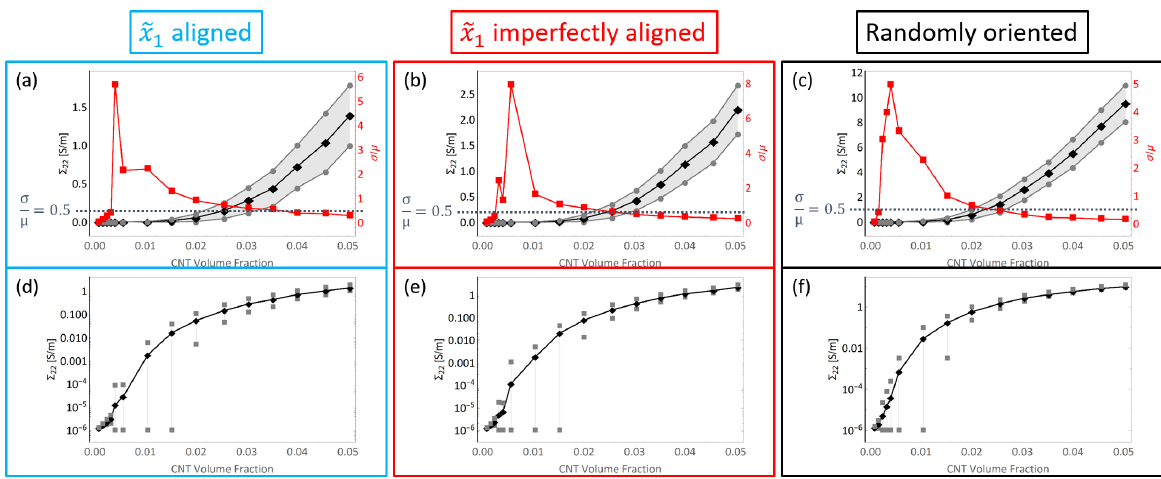
Figure 14. The mean, mean ± standard deviation and coefficient of variation are depicted in black, grey and red, respectively, for Σ 22 for ( a ) straight ˜ x 1 aligned CNTs, ( b ) straight ˜ x 1 imperfectly aligned ( ± 15 ◦ ) CNTs and ( c ) straight randomly oriented cases, respectively. The mean and mean ± standard deviation are depicted in black and grey, respectively, for Σ 22 in semi-log plots for ( d ) straight ˜ x 1 aligned, ( e ) straight ˜ x 1 imperfectly aligned and ( f ) straight randomly oriented cases,